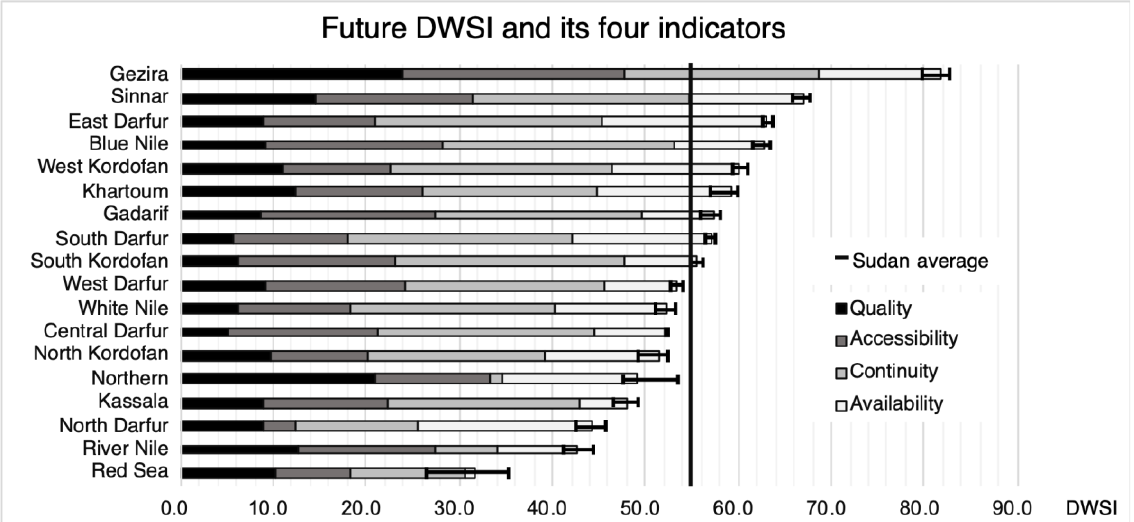
Figure 3. Ranking of the 18 states according to their future DWSI, with the indication of uncertainty ranges.